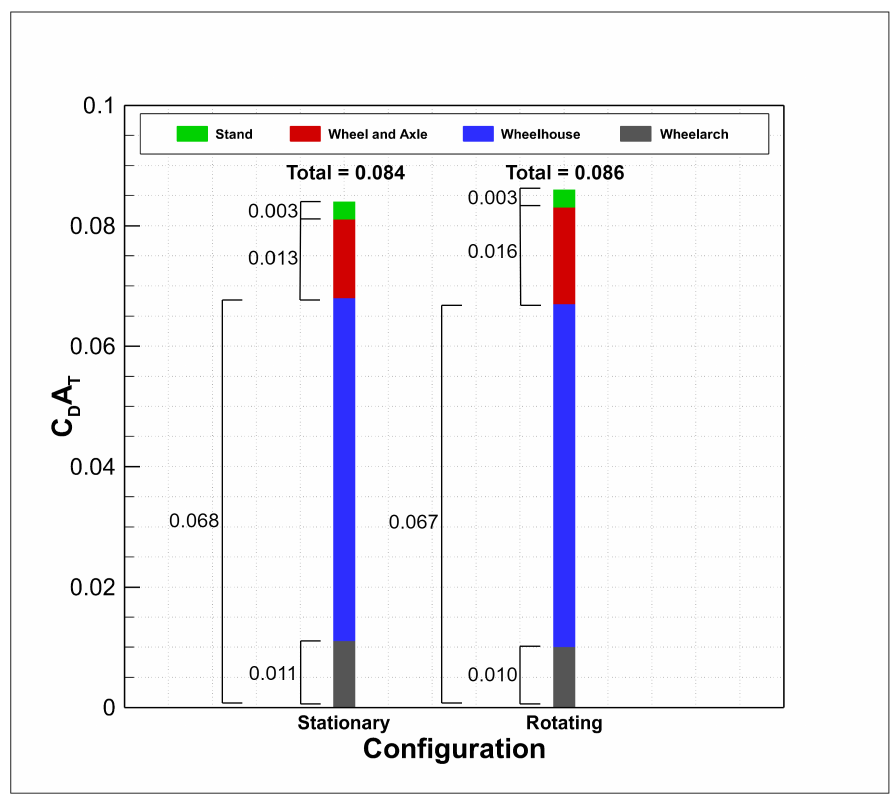
Figure 14. CFD: Stationary and Rotating Wheel Drag